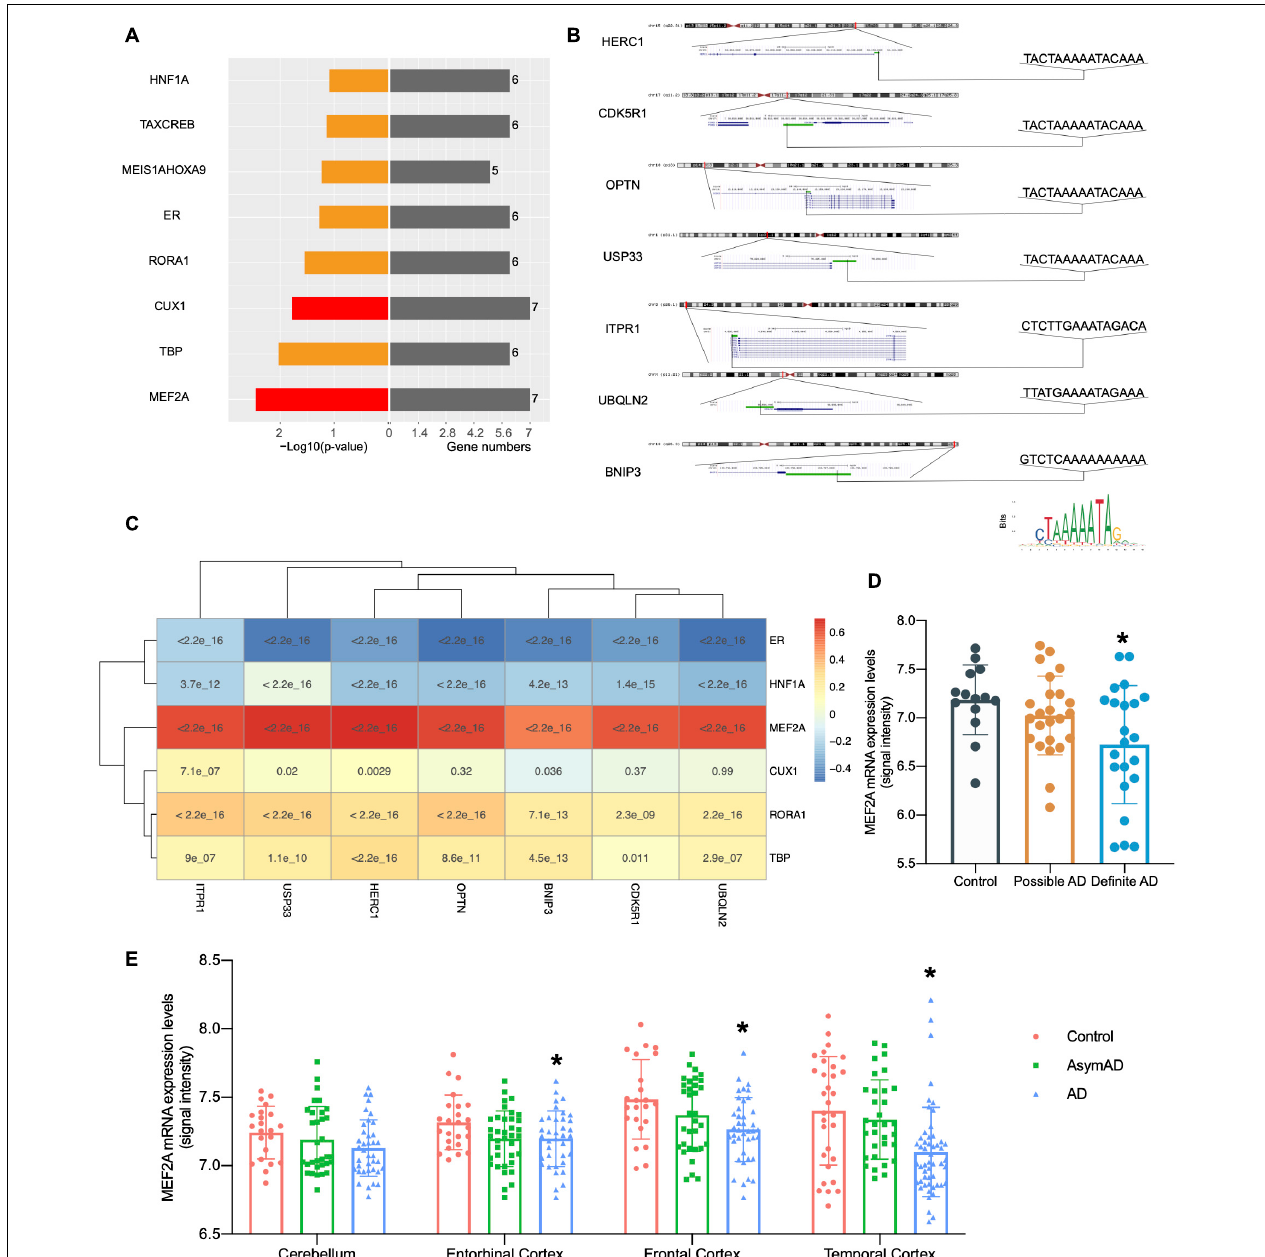
FIGURE 3 | Relationship between MEF2A expression and the screened seven genes. (A) Transcription factors were investigated from the UCSC database with online annotation website DAVID; transcription factors correlated with all the screened seven genes are indicated in red. In the left section, -log10( p -value) values are shown, and gene numbers enriched are shown in the right section. (B) The motifs of the screened seven genes matched to MEF2A ( p < 0.001) were scanned by MEME tools (described in Methods section “Transcription Factors Enrichment”) and were shown in UCSC. The positions and sequences of the screened seven genes were inquired in UCSC, and promoters (shown as green bar) were defined as the 2,000 bp window centered on the transcript start site of genes. The motif of MEF2A downloaded from JASPAR 2020 is shown on the bottom right. (C) Correlations between transcription factors and the expression levels of BNIP3, CDK5R1, HERC1, ITPR1, OPTN, UBQLN2, and USP33 were analyzed (Pearson’s correlation) in the dataset GSE84422 (Wang et al., 2016) and was shown as the heatmap. (D) The dataset GSE84422 (Wang et al., 2016) was downloaded, and the mRNA expression (signal intensity) of MEF2A in different neuropathological category of sample (possible AD group, control group, and the definite AD group) were shown using GraphPad. ANOVA followed by LSD test was used for comparison among groups. * p < 0.05 compared with the control group. (E) The dataset GSE118553 (Patel et al., 2019) was downloaded and the mRNA expression (signal intensity) of MEF2A in different groups (AD, AsymAD, and control group) and brain regions of sample (cerebellum, entorhinal cortex, the frontal cortex and temporal cortex) were shown using GraphPad. An ANOVA followed by an LSD test was used for comparison among groups. * p < 0.05 compared with the control group.